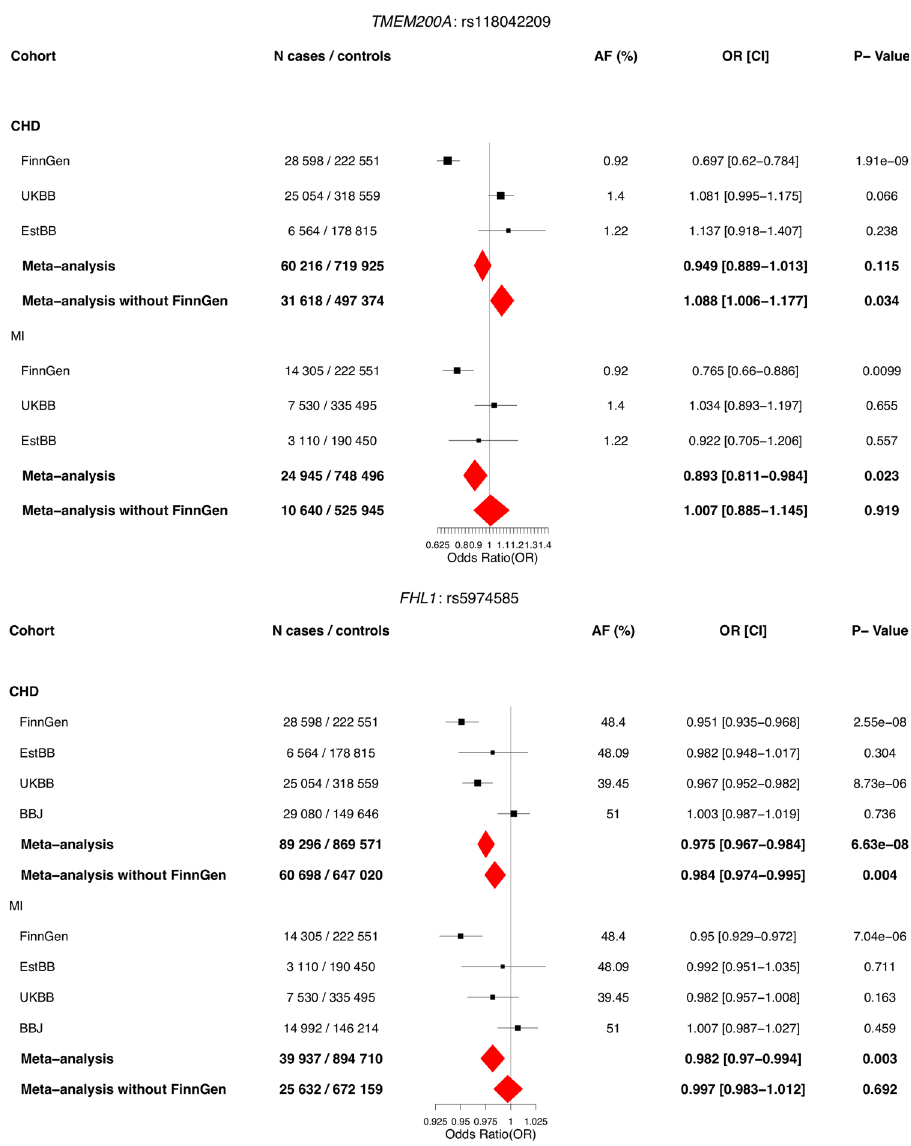
Fig. 3 Results for rs118042209 in TMEM200A and rs5974585 in FHL1 against coronary heart disease and myocardial infarction across different cohorts across cohorts where available. Logistic regression has been applied, adjusted for age and sex. Meta-analysis was performed using inverse- variance weighted fi xed-effects meta-analysis method. Black dots represent odds ratios, and lines 95% con fi dence interval from the single cohorts and red diamonds represent the results from meta-analysis ends of the diamonds representing the ends of the 95% con fi dence interval. Source data for the fi gure is in Supplementary Data